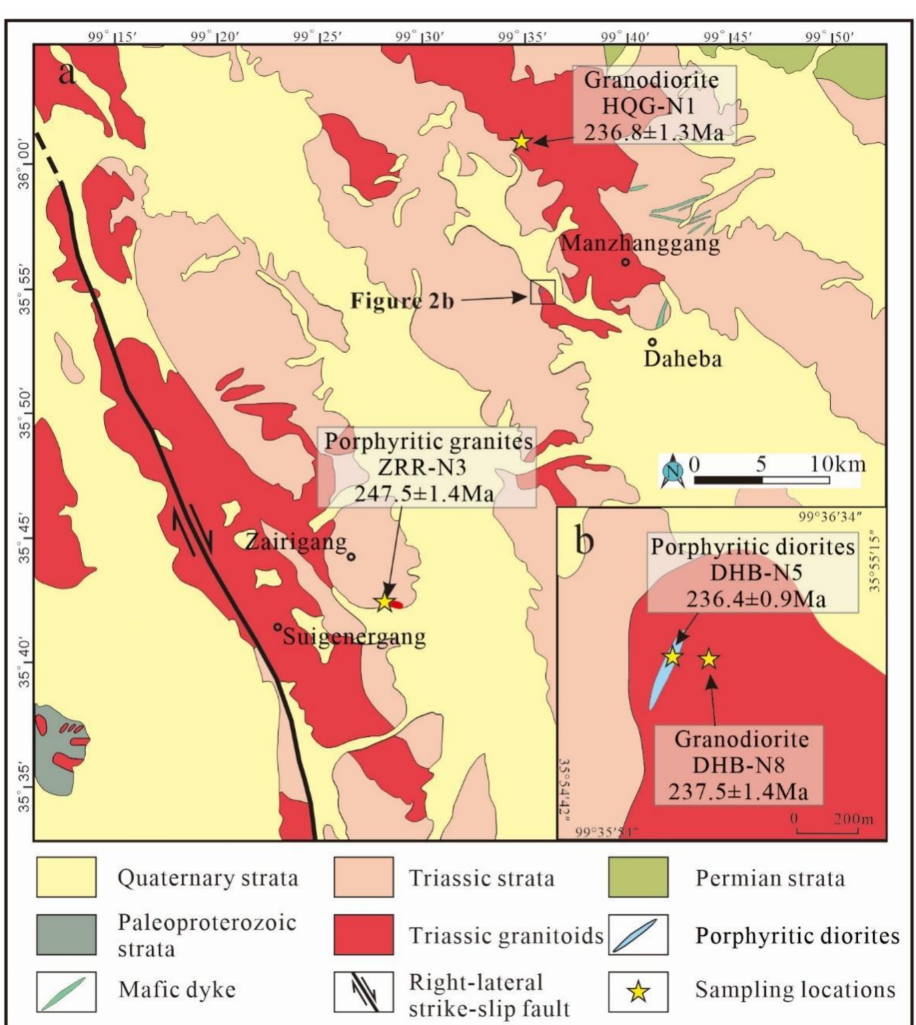
Figure 2. ( a ) Detailed geological map of the Ela Mountain area showing the sampling locations (Modified after 1:250,000 geological maps from the comprehensive geological map of Xinghai and Chaka County, Qinghai Province). ( b ) Detailed geological map of the Daheba area showing the sampling locations ( modified after 1:10,000 geological map of Daheba polymetallic mining area in Qinghai